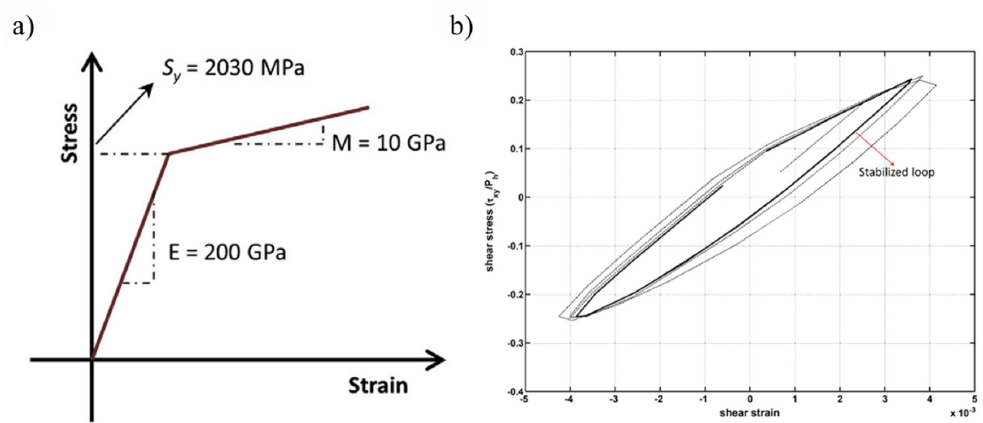
Figure 6. ( a ) The elastic linear kinematic plastic (ELKP) stress–strain curve acquired from the torsional testing of bearing steel; ( b ) the shear cyclic stress–strain hysteresis loop generated by multiple rolling cycles [62].